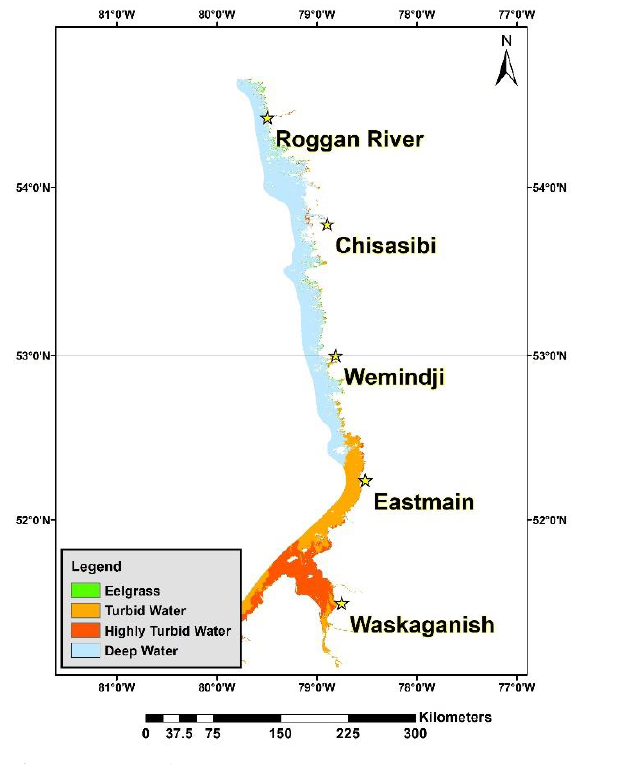
Figure 9. Classified image produced by applying the Random Forests classifier to both Landsat-8 OLI images outlining the coastline around Wemindji.